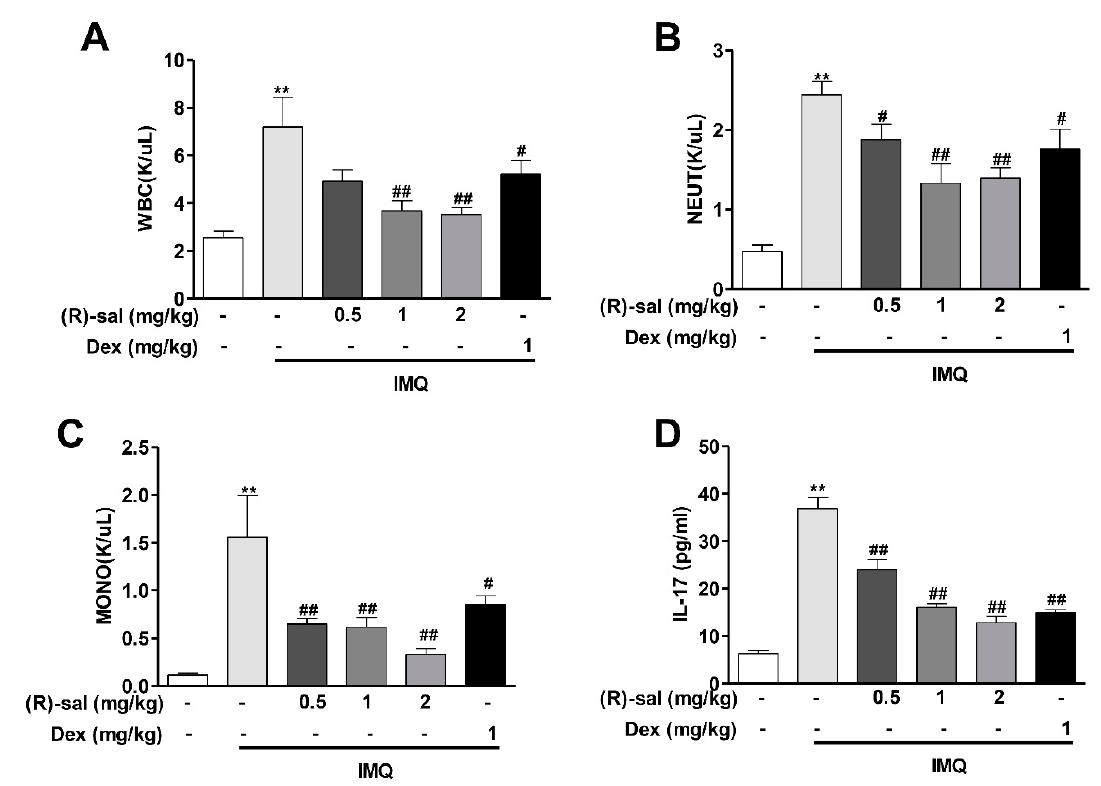
Figure 4. ( R )-salbutamol reduced the levels of leukocytes in the blood and reduced IL-17 in the plasma. ( A ) white blood cells (WBC), ( B ) Neutrophil, ( C ) Monocyte were analyzed using IDEXX ProCyte DX hematology analyzer. ( D ) Levels of IL-17 in mouse plasma were measured by ELISA. # p < 0.05, ## p < 0.01, compared with IMQ group. ** p < 0.01, compared with control group. Each bar represents the mean ± SD ( n = 8).